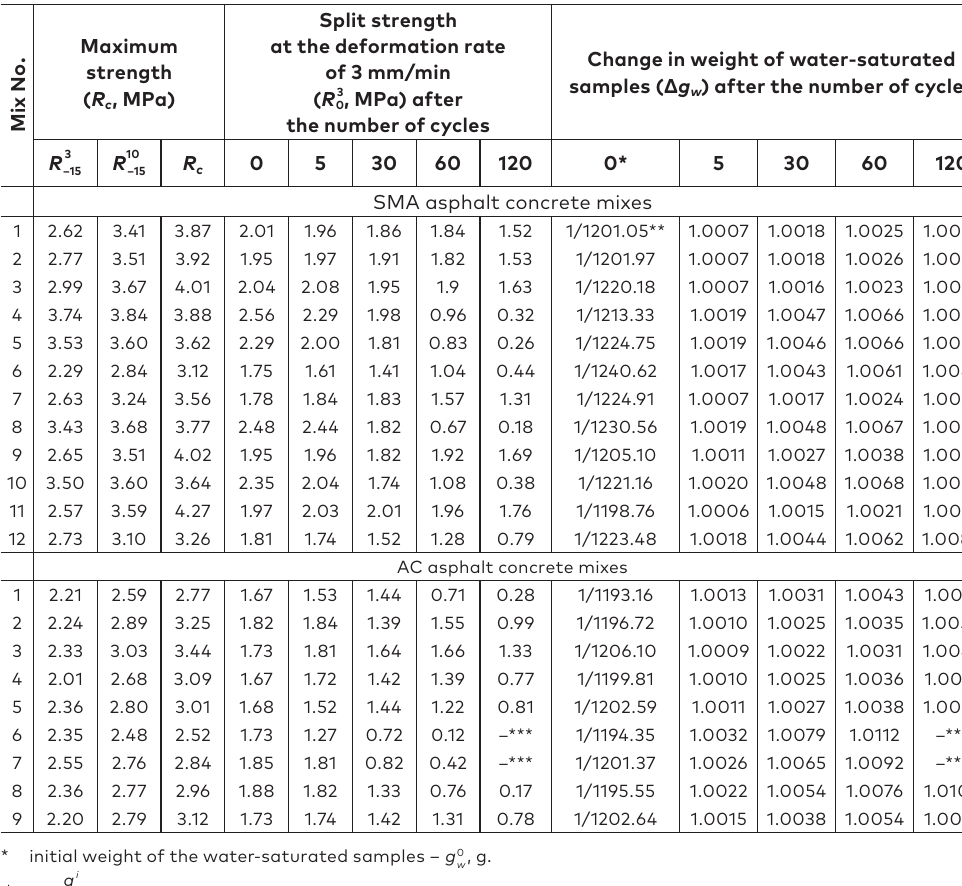
Table 1. Asphalt concrete mixes test